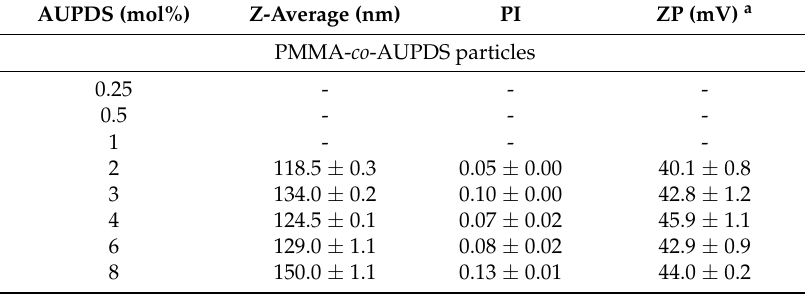
Table 1. Z-average hydrodynamic diameters, polydispersity index (PI), and zeta potential (ZP) values obtained for PMMA- co -AUPDS and for PS- co -AUPDS particles with different amounts of AUPDS. Values are presented in average ± standard deviation ( n =